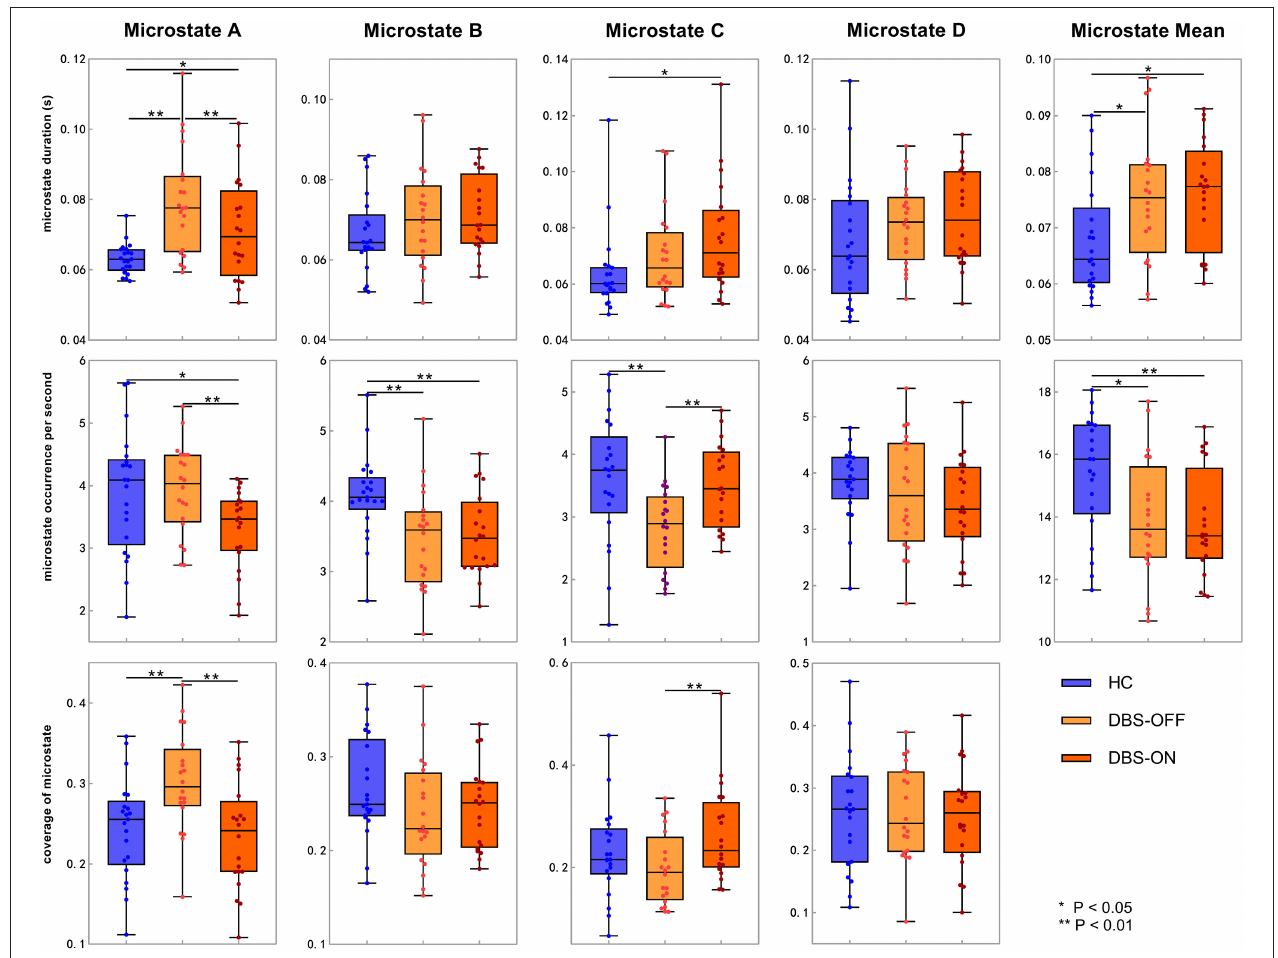
FIGURE 2 | Temporal characteristics of microstate. Between-groups comparison of microstate duration, occurrence per second, and coverage for each microstate class separately. The p -values result from the independent samples t -test between HCs and patients with PD with DBS-OFF state and DBS-ON state separately and a paired t -test between PD patients with DBS-OFF state and DBS-ON state. DBS, deep brain stimulation; HC, healthy